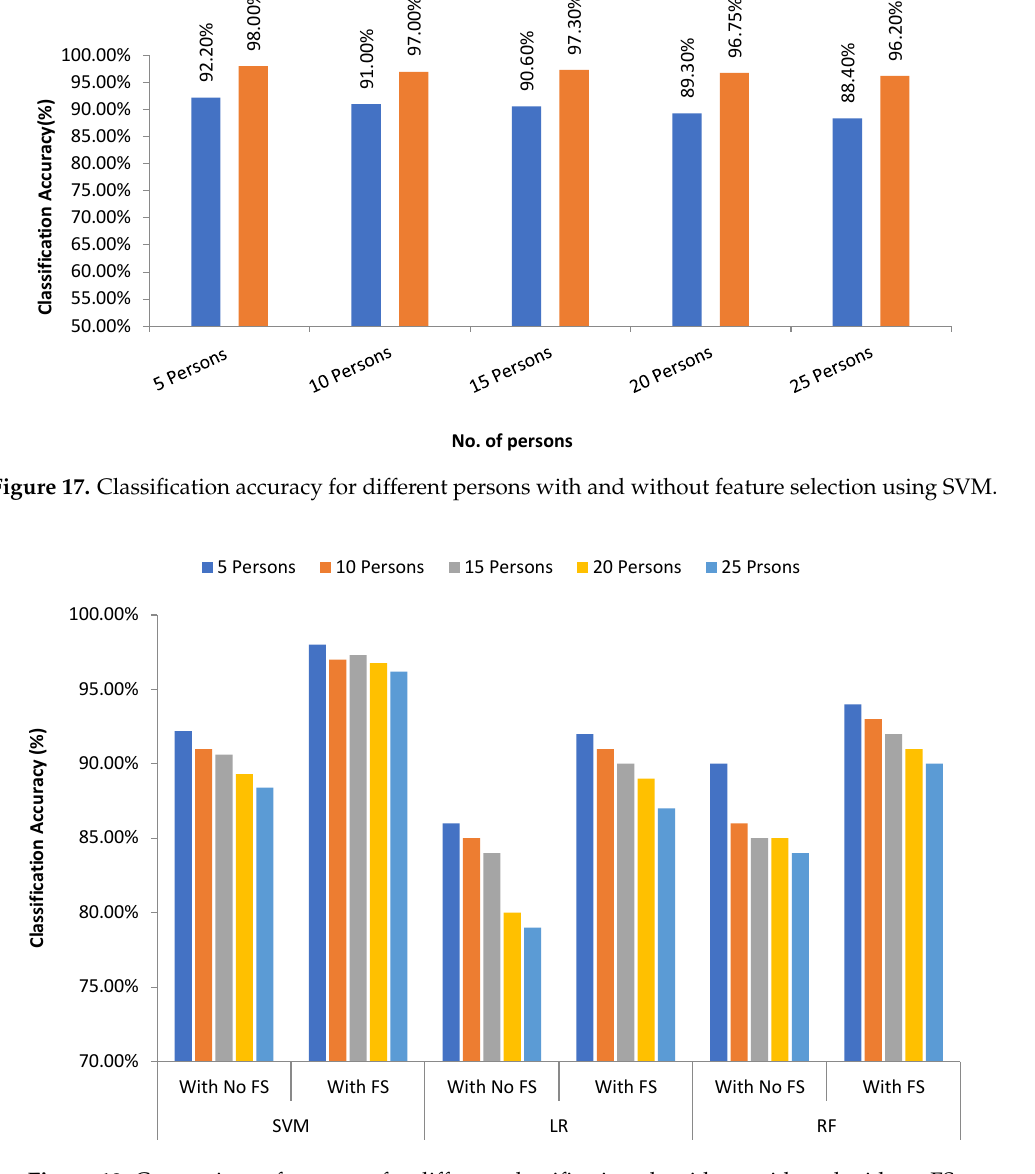
Figure 19. Class-wise accuracy (%) comparison of the proposed model with state-of-the-art im- age-based system. Table 8 presents a comparison summary of our proposed system with some existing studies. From Table 8, we can see that our self-collected pen-tablet data are more robust in terms of noise effect compare to image-based. And our model outperforms with low computational costs.